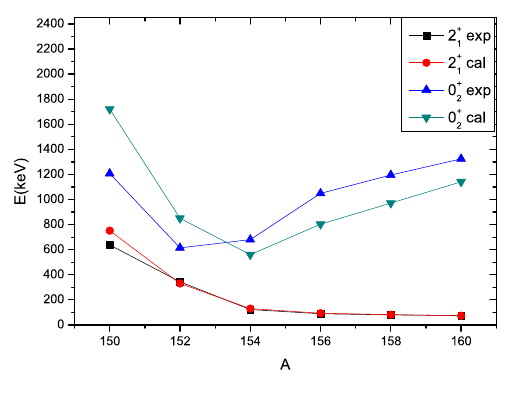
Figure 2. (Color online) Comparison of calculated first 2 + state and second 0 + state for 150 − 160 Gd with the experimental data, taken from Refs. [18–23].